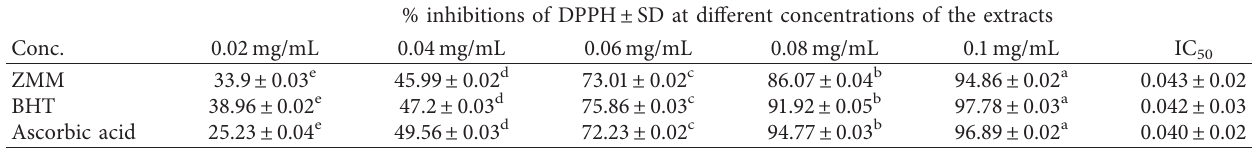
Table 2: DPPH inhibition (%) by the methanol extract of Z. mucronata . % inhibitions of DPPH ± SD at different concentrations of the extracts Conc.